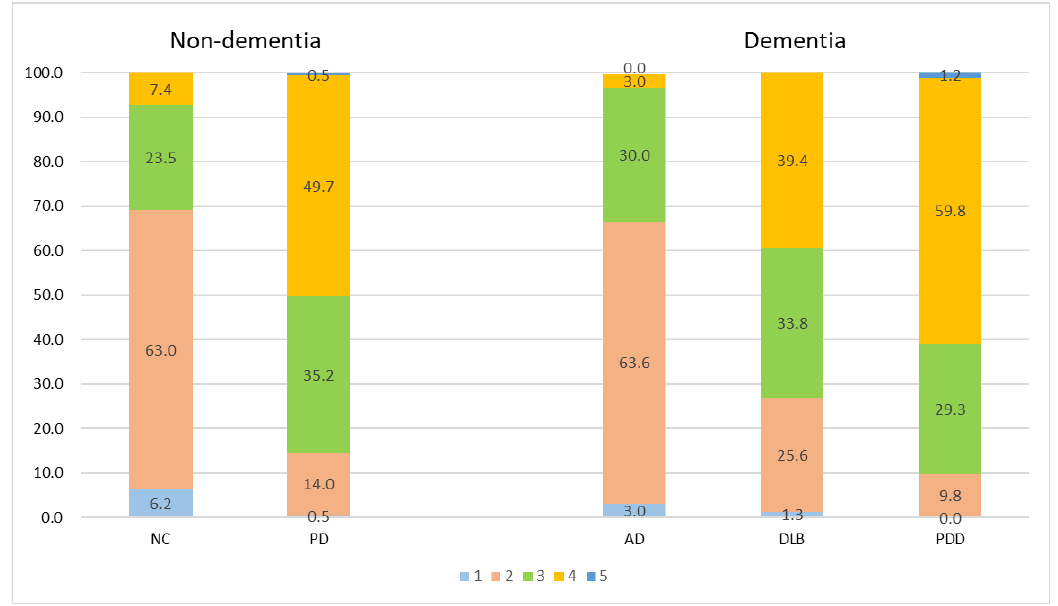
Figure 3. Percentage frequency of ML-VS in different groups. All comparison groups in non-demen- tia and dementia groups were significantly different (all p < 0.001). Different colors represent different MT-VS scales. MT-VS